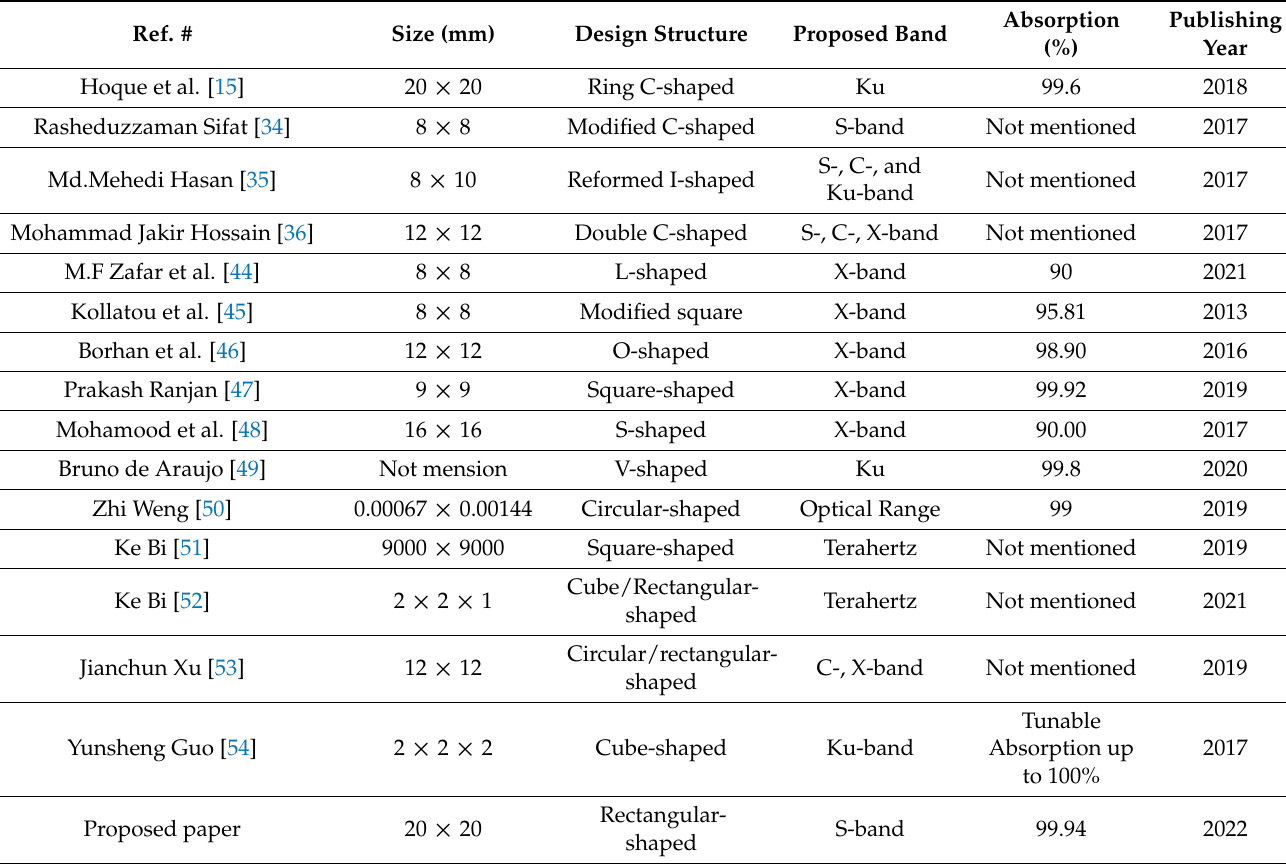
Table 1. Comparison of the high-absorption S-band absorber with those featured in published